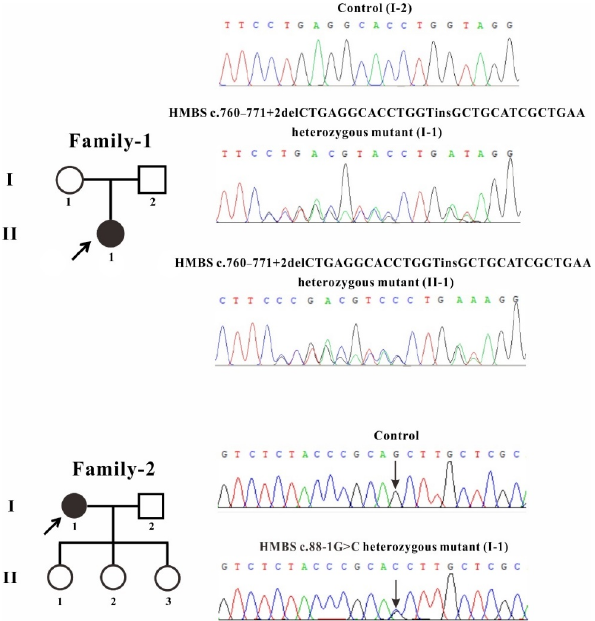
Figure 1. Pedigree and sequencing of patients from two unrelated Chinese families. The patient involved in this study is pointed by an arrow. Sanger sequencing analysis performed on the genomic DNA from indicated patients. The gene variation is shown by a black arrow.